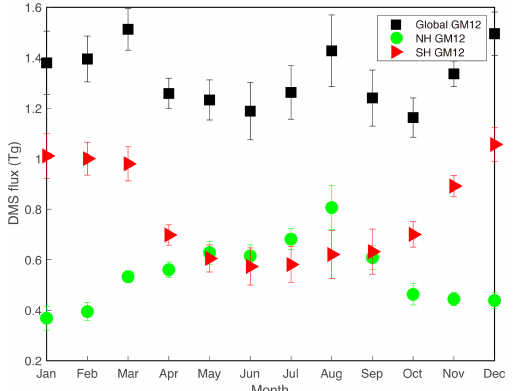
Figure 8. Area and month integrated DMS sea-to-air flux (TgSmonth − 1 ) based on GM12 parameterization. Red triangles represent monthly mean flux of the Southern Hemisphere, green dots represent monthly mean flux of the Northern Hemisphere, and black squares represent the global monthly mean flux. Uncertainties are estimated based on the top 10 models with different parameter combinations. Error bars correspond to ± 1 σ